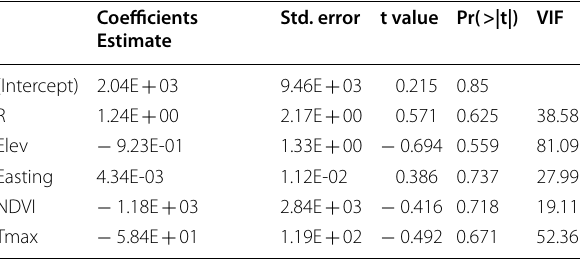
Table 9 Statistical results for full regression of the relationship between spatial PET and landscape-climate predictors for the mean annual. The climatic variables included in the analysis were mean elevation, mean annual rainfall, easting, NDVI, and maximum temperature